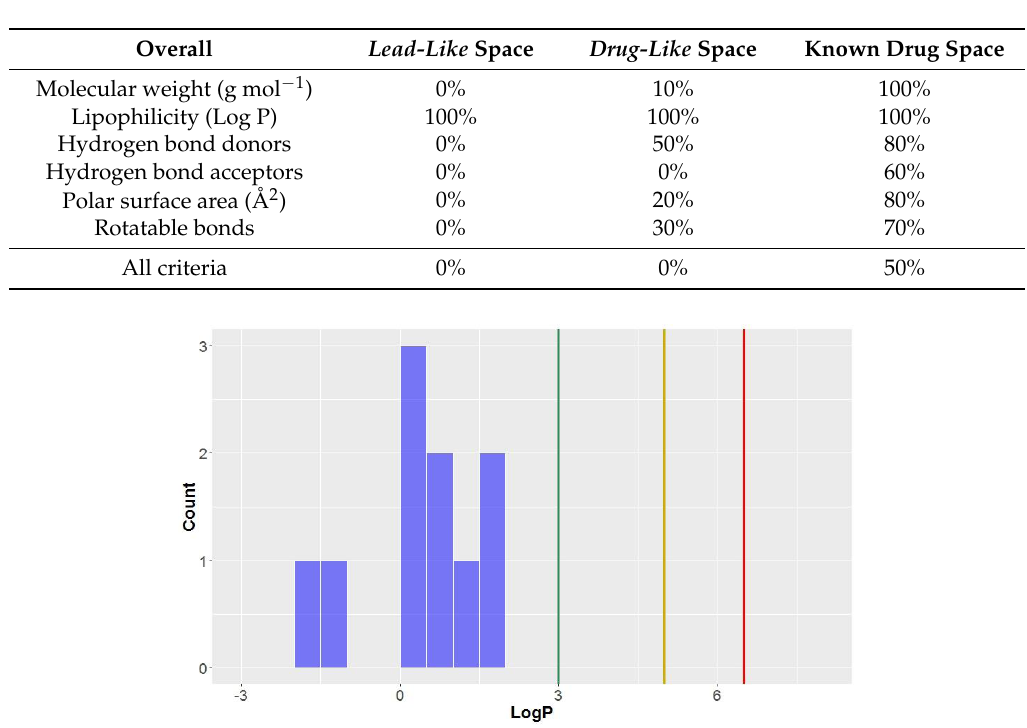
Table 6. CLCs studied within the defined chemical spaces.